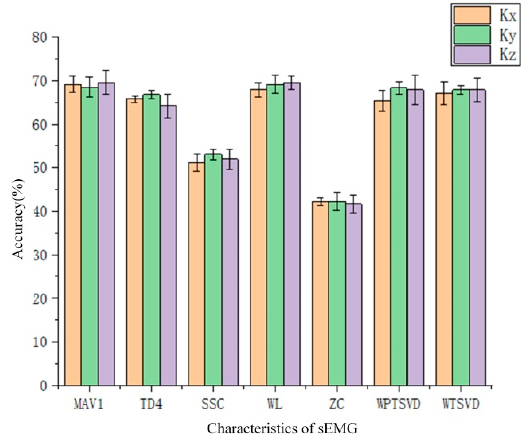
Figure 7. Accuracy of stiffness classification with KNN.